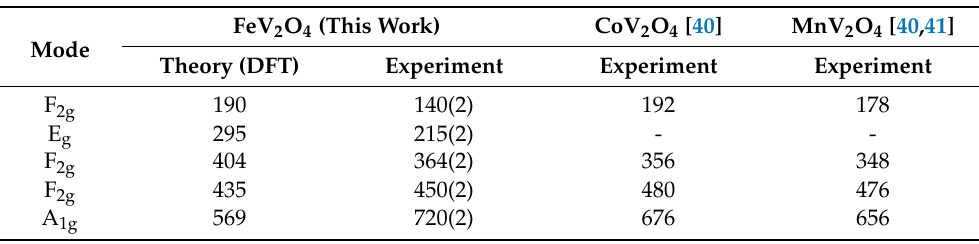
Table 1. Experimental and calculated Raman mode frequencies (cm − 1 ) of spinel FeV 2 O 4 at ambient conditions compared with those of other isostructural vanadates. FeV 2 O 4 (This Work) CoV 2 O 4 [40] Mode Experiment